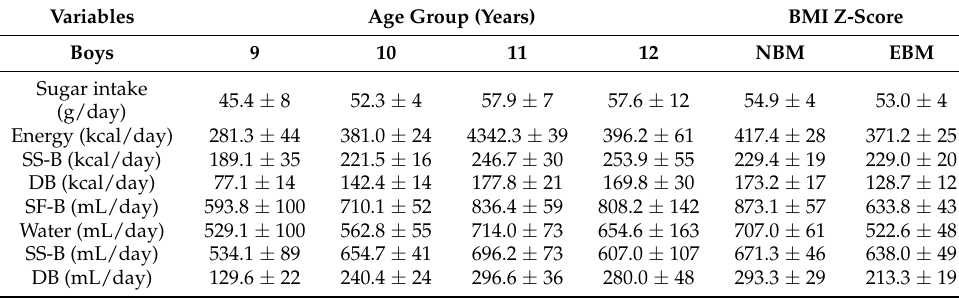
Table 2. Beverage intake pattern by children from the Mexico–USA